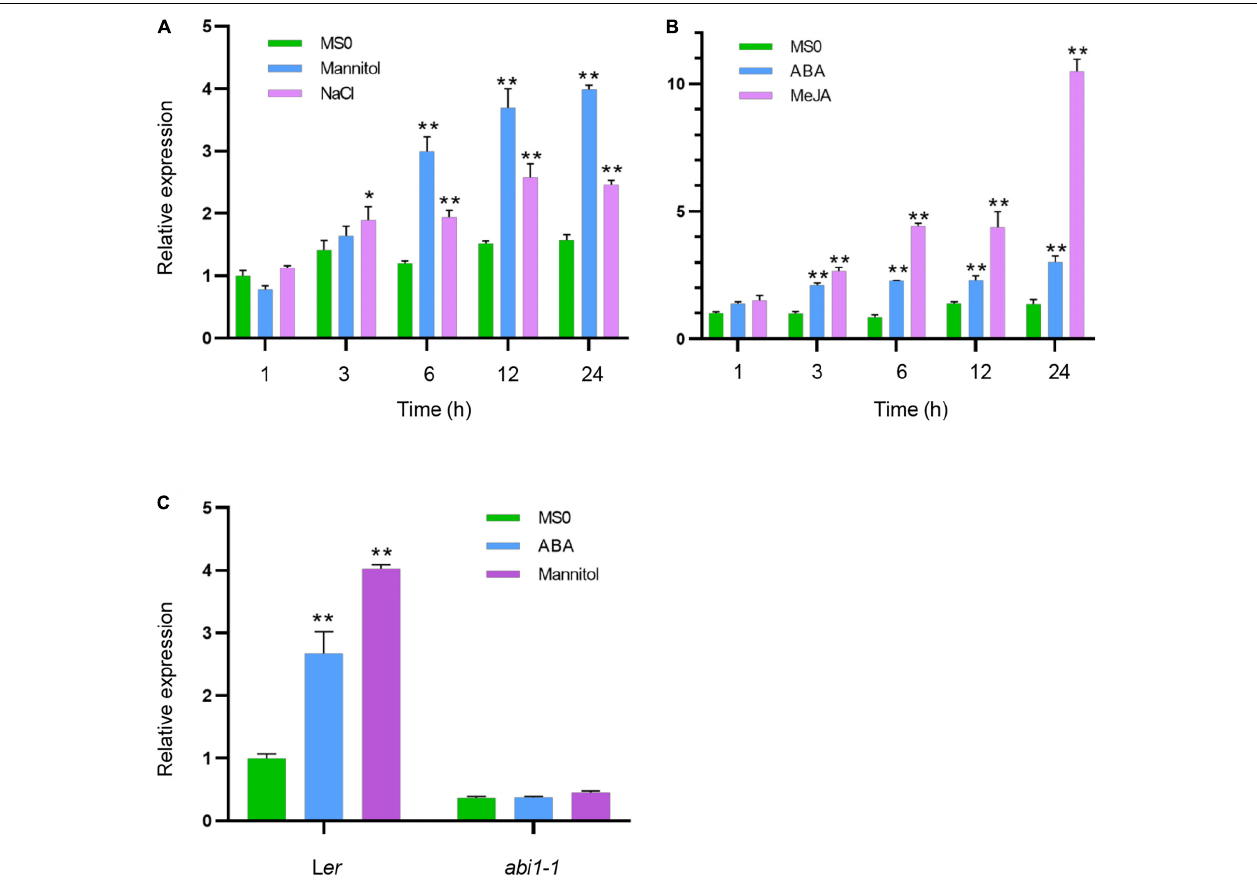
FIGURE 1 | The expression of ALKBH10B is induced by virous external stimuli. (A,B) ALKBH10B expression in Col-0 plants in response to osmotic stress, salt stress, ABA, and MeJA. Seven-day-old seedlings were transferred to solid 1/2 MS medium, medium with 300 mM mannitol or 150 mM NaCl, or liquid 1/2 MS medium, medium with 50 µ M ABA or 50 µ M MeJA, respectively. After treated with the indicated time, seedlings were harvested followed by RNA extraction and cDNA synthesis for qRT-PCR. Asterisks indicate statistically significant differences as compared to the mock of every time-point (* P < 0.05; ** P < 0.01; Student’s t -test). (C) ALKBH10B expression in abi1-1 mutant in response to ABA and mannitol. Seven-day-old seedlings were transferred to solid 1/2 MS medium or medium containing 50 µ M ABA or 300 mM mannitol for 24 h, respectively. Then seedlings were harvested followed by qRT-PCR. The transcript level of ALKBH10B were normalized to the At2G28390 expression. Error bars represent the standard deviation of three replicates. Asterisks indicate statistically significant differences (* P < 0.05; ** P < 0.01; Student’s t -test).